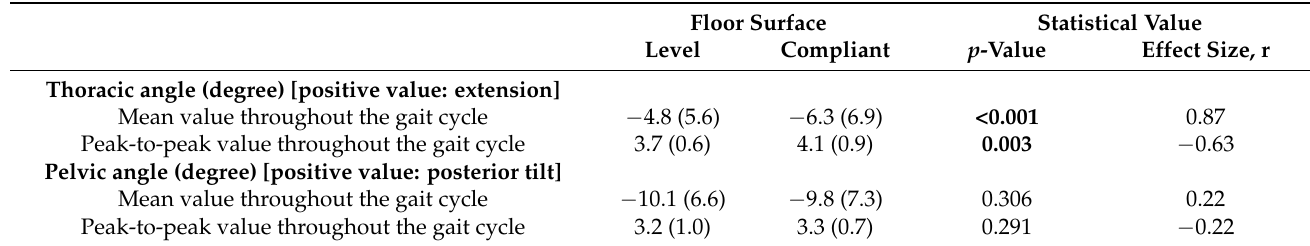
Table 4. Trunk angle during walking on the level and compliant